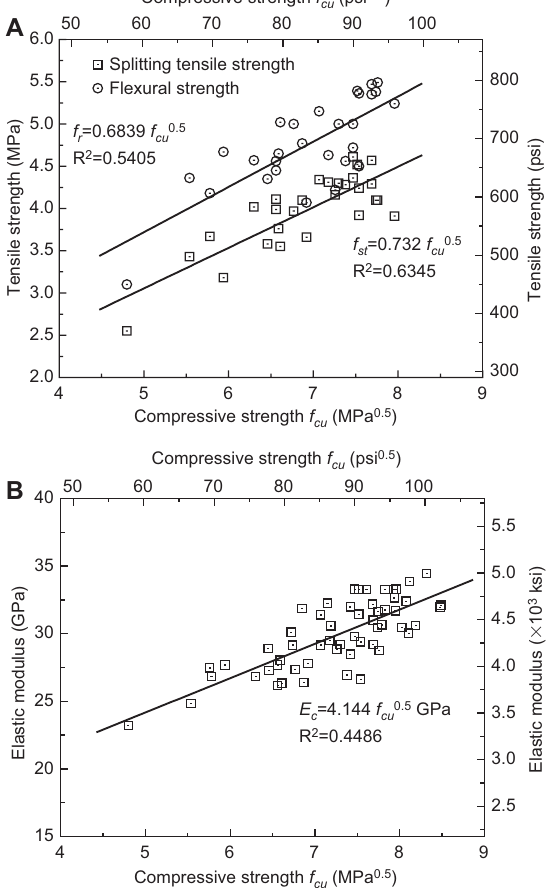
Figure 6 Relation between compressive strength and (A) tensile strength, and (B)